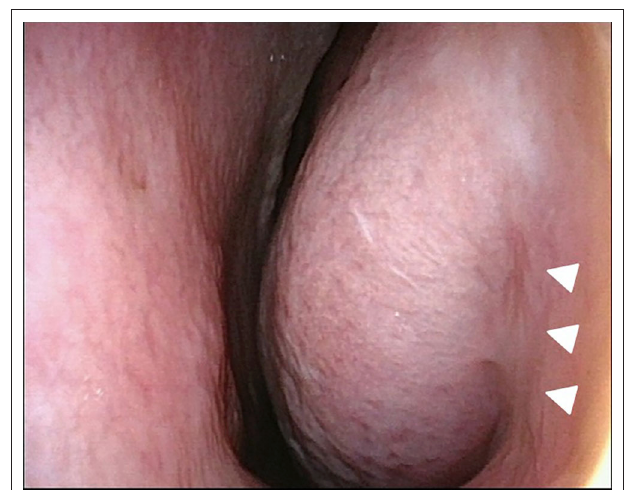
FIGURE 1 | Flexible endonasal fiberscopic findings of the left nasal cavity. Hypertrophy of the left inferior turbinate was present, and the left inferior nasal meatus had disappeared (white